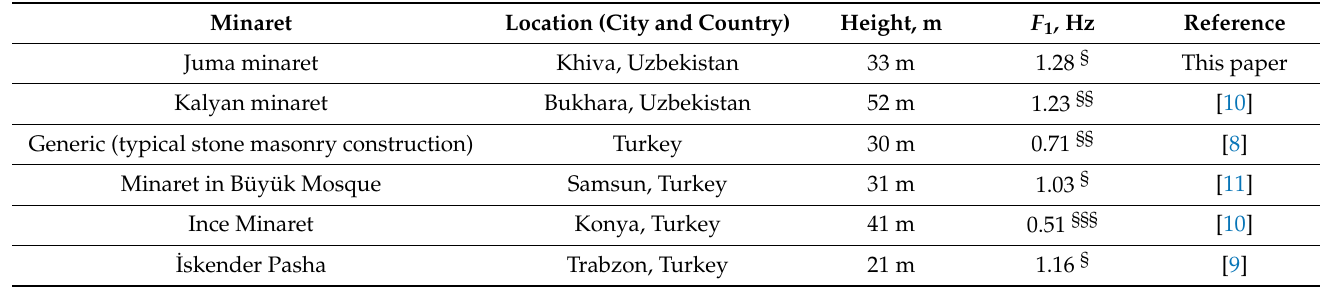
Table 8. Comparative analysis of the first resonant frequencies of a few